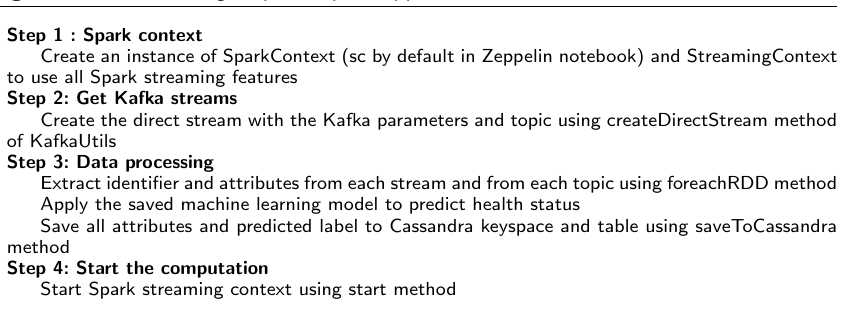
Algorithm 4 Processing steps of Spark application